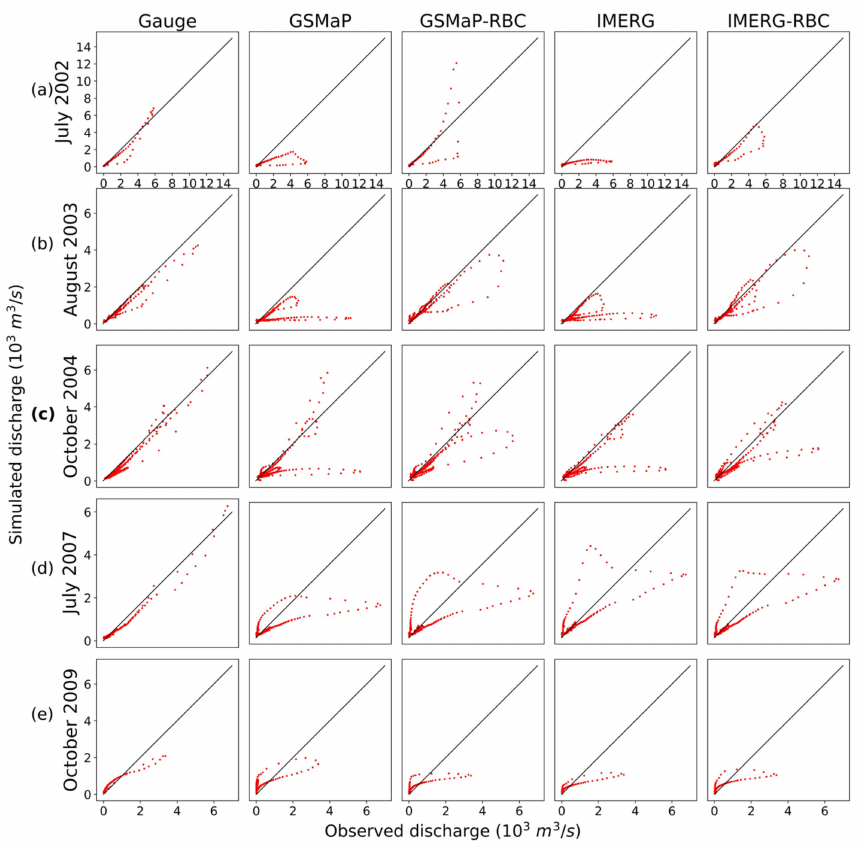
Figure 7. Scatterplots between observed and simulated discharge for five precipitation datasets and five cases. ( a )–( e ) represent five cases